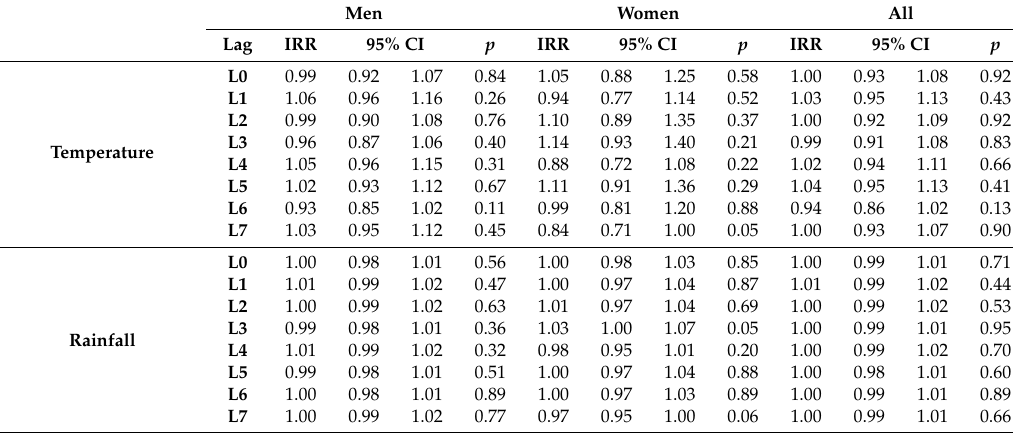
Table 3. Fixed Poisson models for the lagged effects of weather variables on daily suicides among men and women in five Colombian cities, 2005–2015.